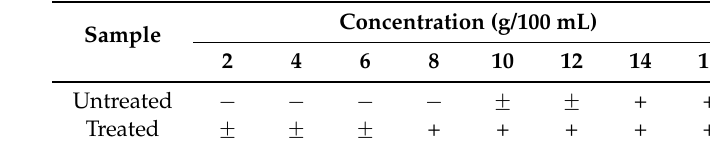
Table 5. Solubility, swelling power and emulsion properties of untreated and alkali-treated defatted rambutan seed flours.